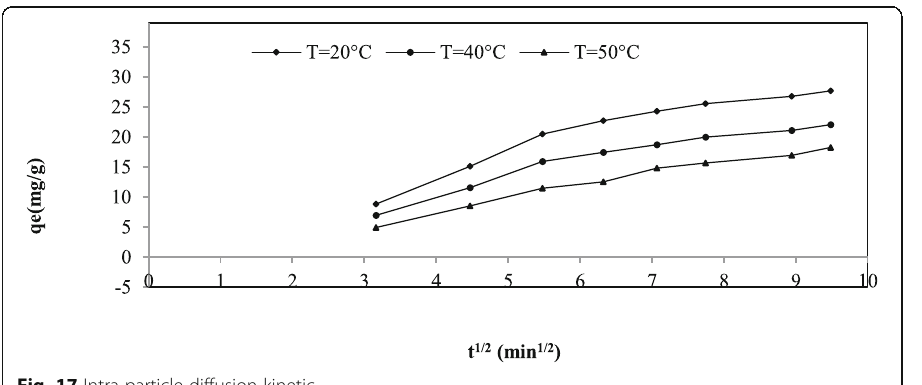
Fig. 17 Intra-particle diffusion